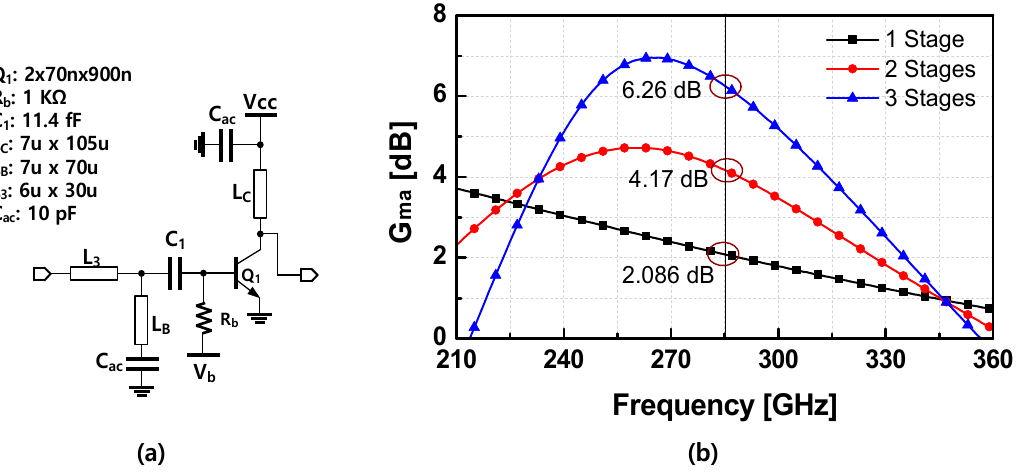
Figure 8. One amplifier unit with interstage impedance matching circuit on schematic level ( a ) and the simulated maximum available gain ( G ma ) of 1, 2, and 3 stages ( b ).